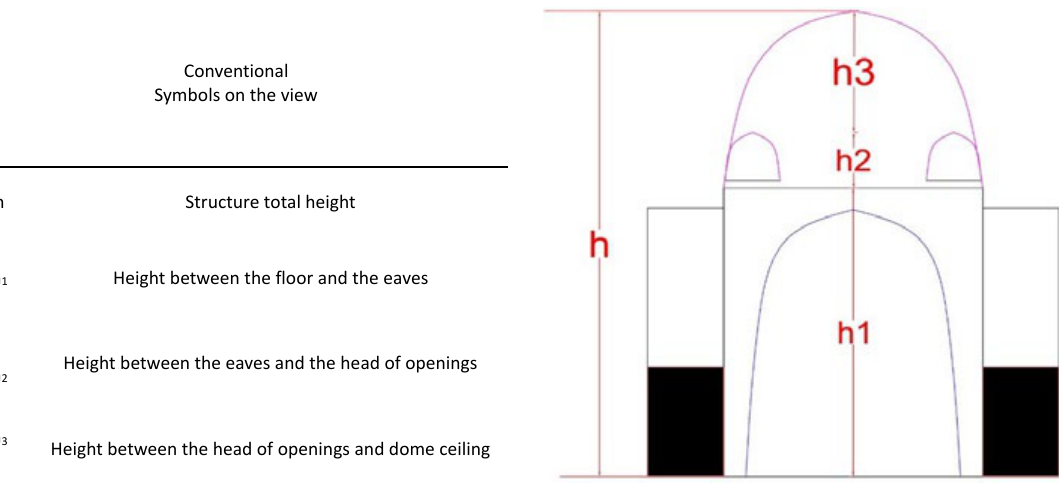
Table 2: Specifications in a square dome elevation designated by conventional symbols Table 2. Specifications in a square dome elevation designated by conventional